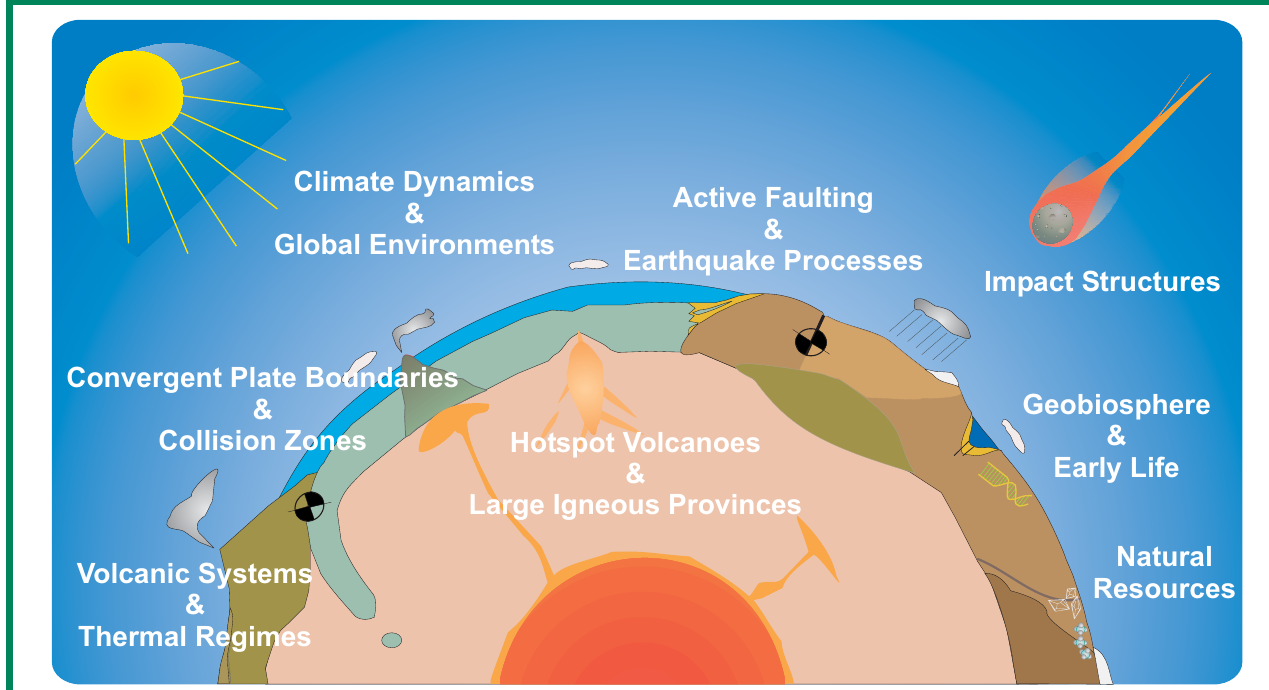
Figure 2. Sketch representing the major scienti fi c themes of the